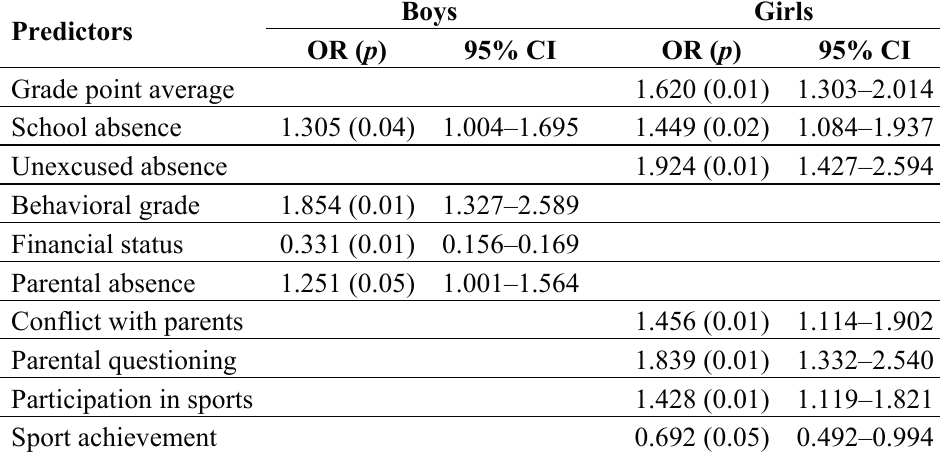
Table 1. Forward conditional logistic regression results for the criterion—smoking incidence among boys and girls (OR—odds ratio; p —level of significance; CI—confidence interval).